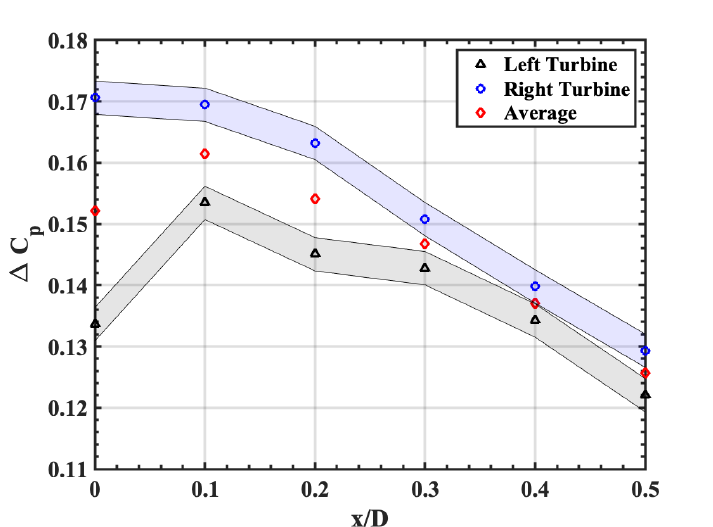
Figure 4. Changes in coefficient of power of lensed turbines at close proximities